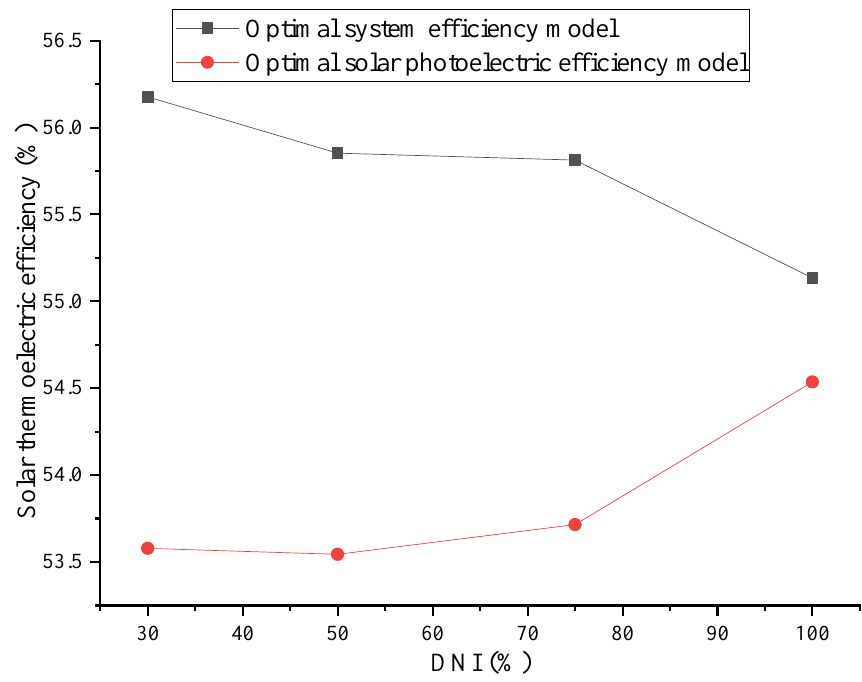
Figure 7. Trend of solar thermoelectric efficiency with DNI reduction for the optimal model of system/solar photoelectric efficiency under design load.